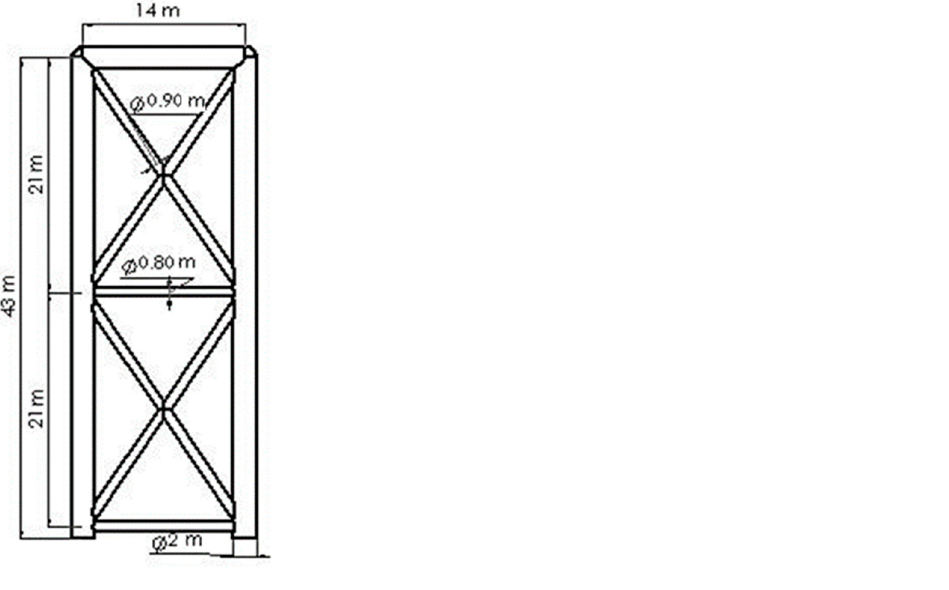
Figure 2. Side view and the dimensions of the jacket-type structure (after Lee et al.,